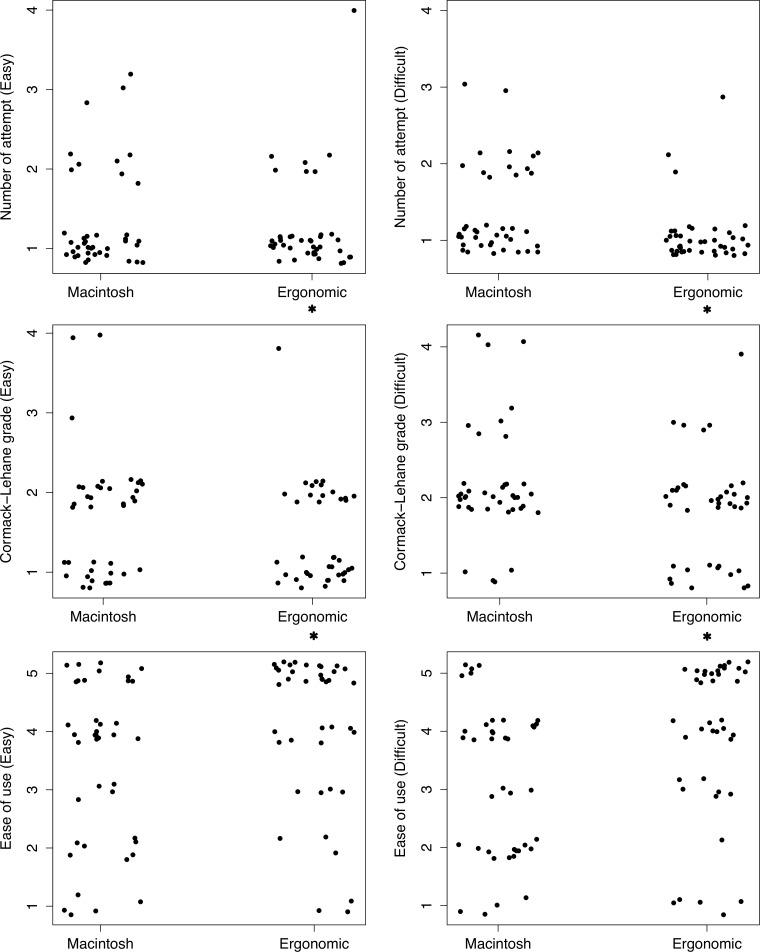
Number of intubation attempts, Cormack-Lehane grade, and ease-of-use scores for intubation groups with and without the ergonomic support grip for easy (left) and difficult (right) airway scenarios; *P < 0.05.